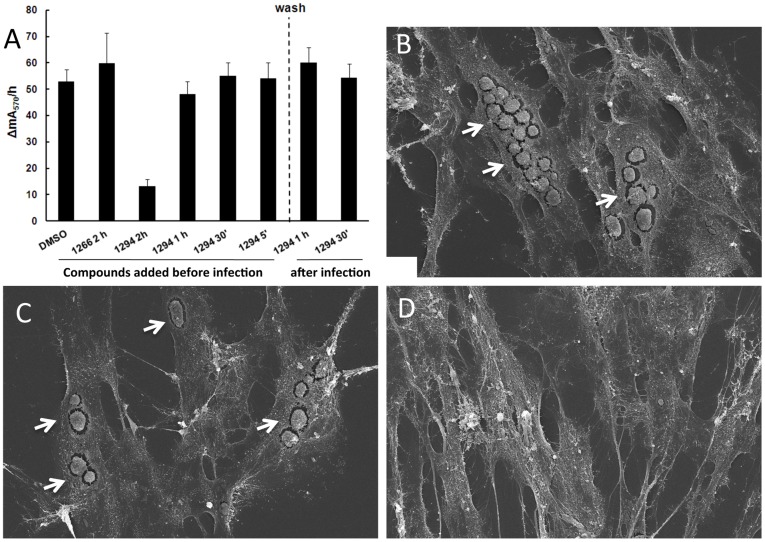
Compound 1294 interferes in host cell invasion.(A) Measurement of β-galactosidase activities in HFF during the invasion process. HFF monolayers were infected by incubating them with 2×104
N. caninum (b-Gal) tachyzoites for 2 hours. Prior to this 2 hour invasion phase (timepoint 0′), tachyzoites were suspended either in DMSO (DMSO 0′), in 5 μM compound 1266 (1266 0′) or in 5 μM 1294 (1294 0′). In additional assays, compound 1294 was added at 60 min after initiation of invasion (1294 60′), 90 min (1294 90′) or 115 min (1294 115′) prior to removal of the drug by washing. Cultures were then incubated for an additional 60 min before β-galactosidase activity was measured. There was a significant decrease in β-galactosidase activity (t-test; p<0.001) when compound 1294 was added at the beginning of infection (1294 0′), but not when the compound was added at later timepoints, and no changes occurred when 1294 was added after the infection phase (1294 60′ post-infection. (B–D) Scanning electron micrographs of HFF infected with N. caninum for 3 days. Cultures were maintained in the absence of 1294 (B), in the presence of 2.5 μM 1294 added 2 h post-invasion (C), and in the presence of 2.5 μM 1294 added already at the time point of invasion (D). Cultures were processed for SEM analysis after 3 days. Note the presence of parasitophorous vacuoles in B and C (arrows), and respective absence in D.